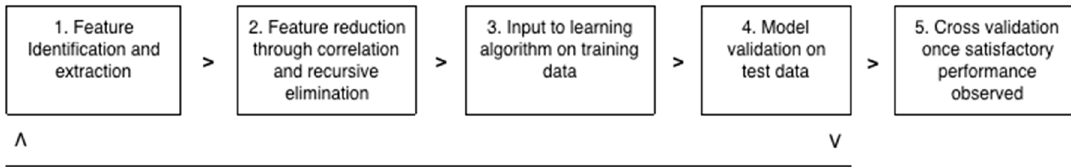
Figure 1. Framework of our predictive model build.